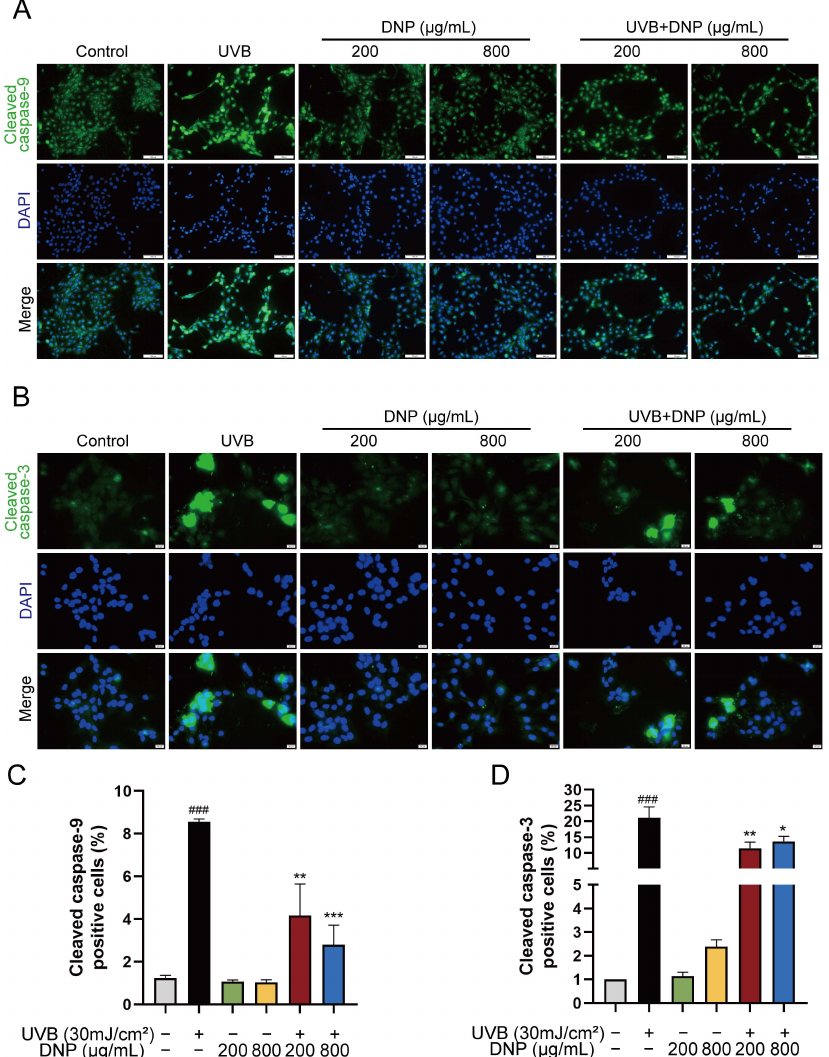
Figure 8. DNPs inhibit UVB-induced apoptosis-related proteins expression in HaCaT cells. ( A ) Repre- sentative fluorescence images showing cleaved caspase-9 staining and ( B ) cleaved caspase-3 staining. Scale bar = 100 µ m ( A )/20 µ m ( B ); Cleaved caspase-9 and cleaved caspase-3 positive cells were counted ( C , D ). ### p < 0.001 vs. control; * p < 0.05, ** p < 0.01, and *** p < 0.001 vs.